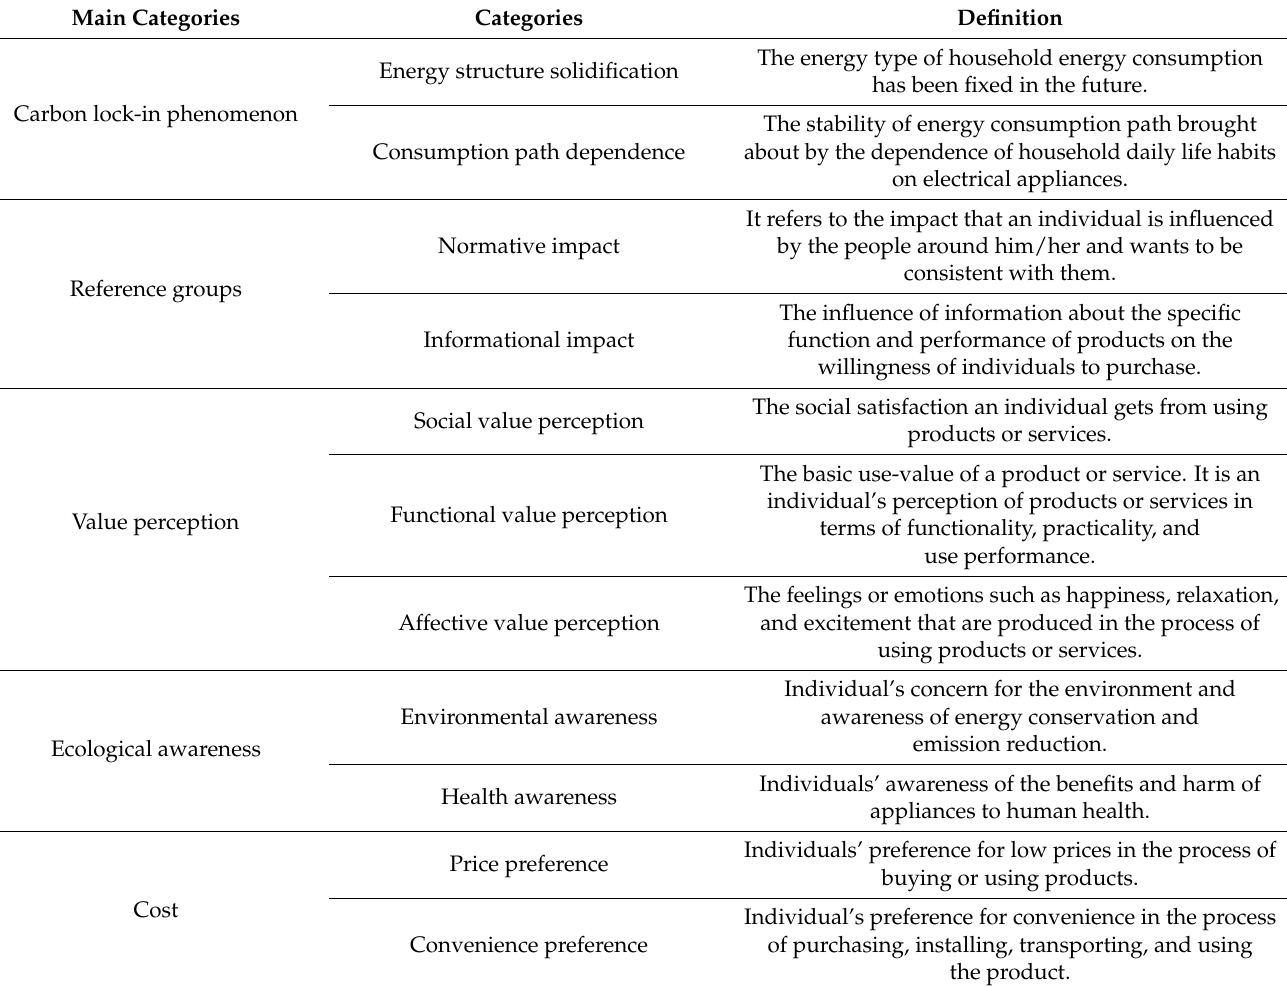
Table 4. Results of axial